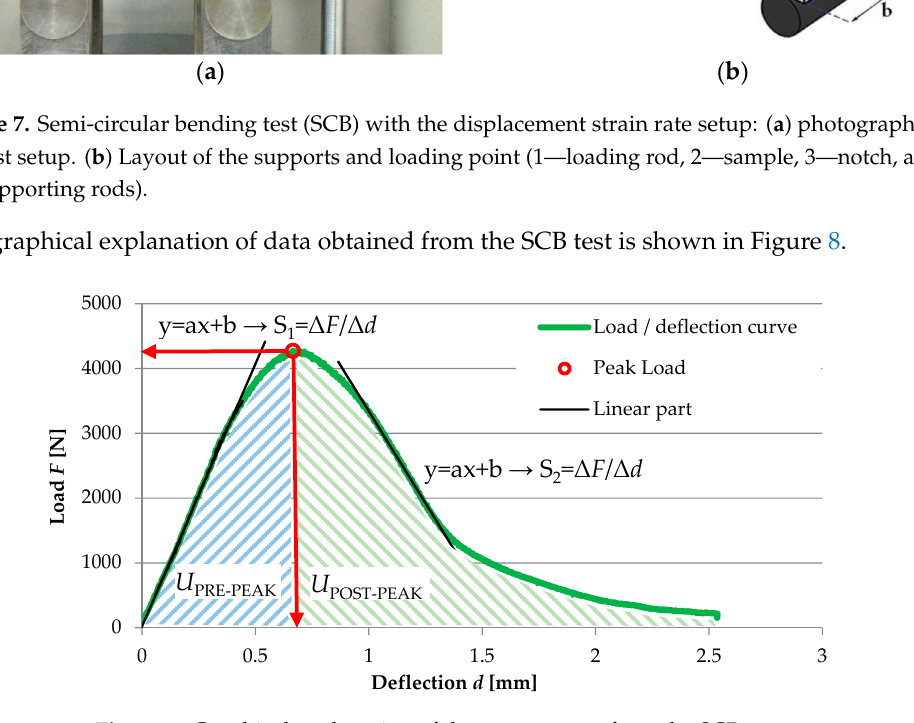
Figure 8. Graphical explanation of data assessment from the SCB test.